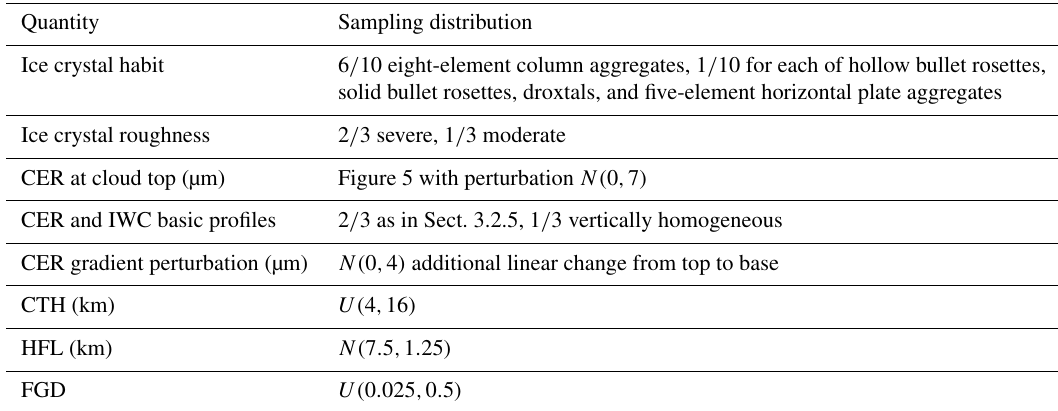
Table 3. Sampling of geophysical parameters for ice cloud perturbation simulations. Quantities not given here are as in Table